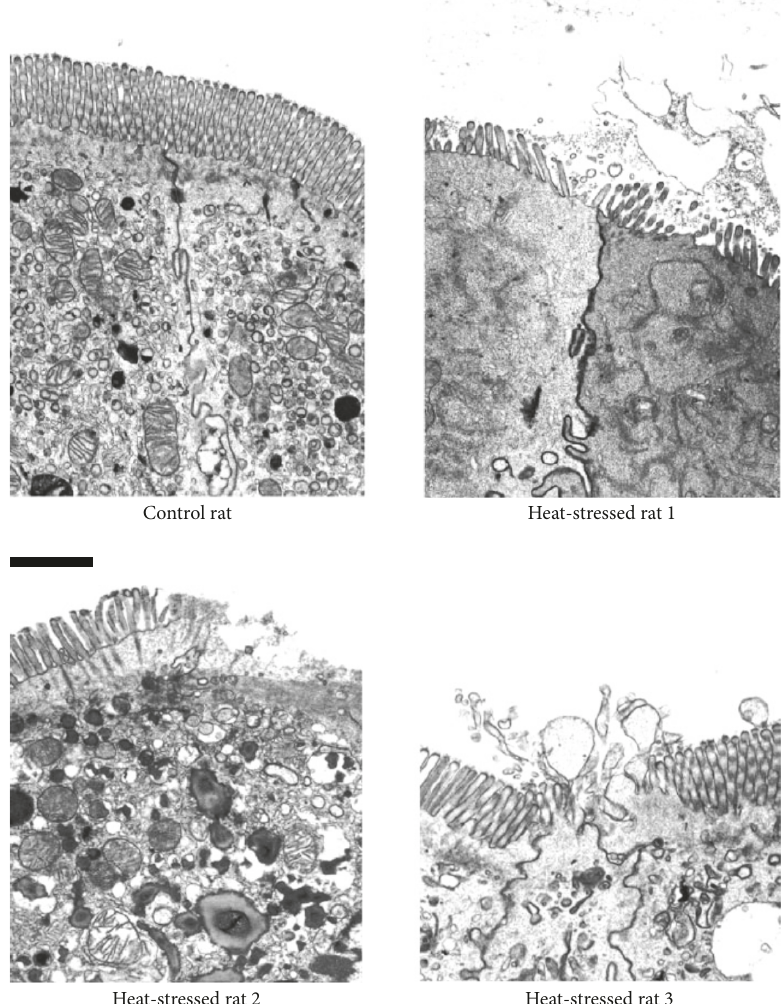
Figure 3: Electron micrographs of small intestine epithelial cells from control and heat-stressed rats. Damage to the microvilli and cell membranes is evident in the heat-stressed rats. Bar represents 1 𝜇 m. Reprinted with permission from Lambert et al.